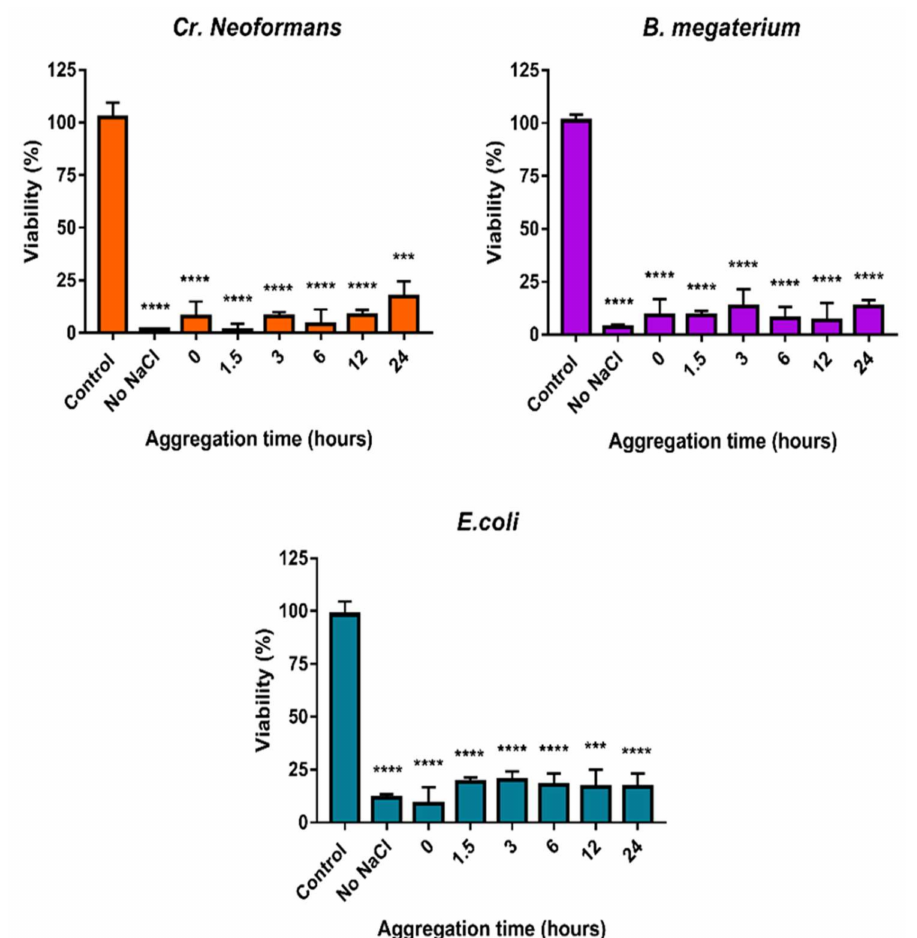
Figure 9. The effect of nanoparticle aggregation on the antimicrobial activity against Cr. neoformans , B. megaterium , and E. coli . Increasing aggregation degree was achieved by incubating the particles with 150 mM NaCl for different time periods (0, 1.5, 3, 6, 12, and 24 h) prior to treatments. The statistical significance of the experiments was calculated through unpaired t -tests and are marked with *** ( p ≤ 0.001), and **** ( p ≤